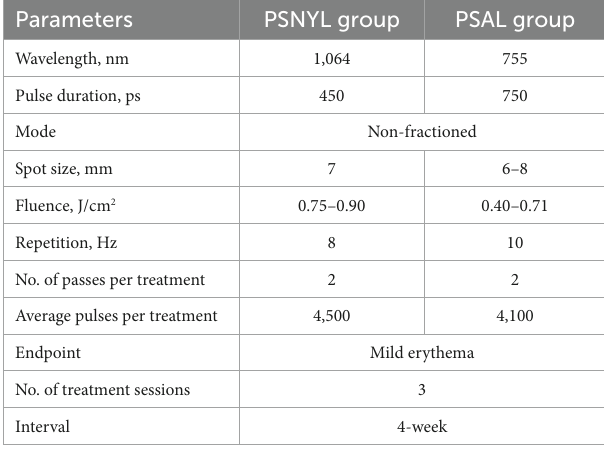
TABLE 1 Laser treatment